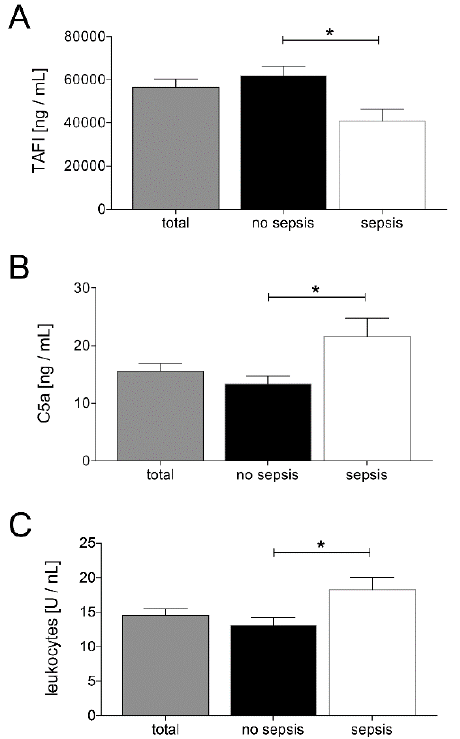
Figure 2. Upon admission of severely injured trauma patients ( n = 48) to the emergency department, plasma thrombin-activatable fibrinolysis inhibitor (TAFI) levels ( A ), plasma C5a levels ( B ), and leukocyte counts ( C ) were determined. Patients were stratified to those who developed sepsis in their clinical course (sepsis, n = 14) vs. those who did not develop infectious complications (no sepsis, n = 34). Data are shown as mean ± SEM. * p < 0.05 sepsis vs. no